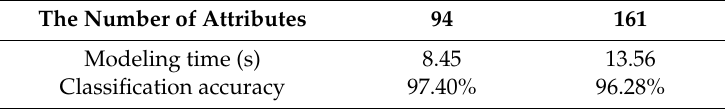
Table 6. The performance of the C4.5 algorithm with di ff erent attribute sets.